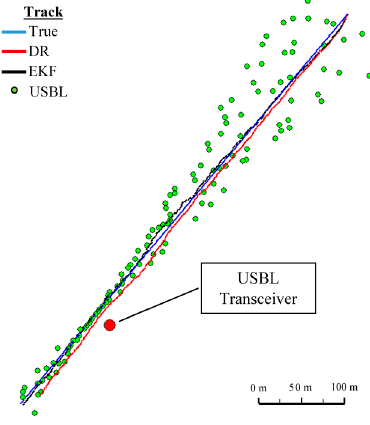
Figure 8. Determined routes (single passage).